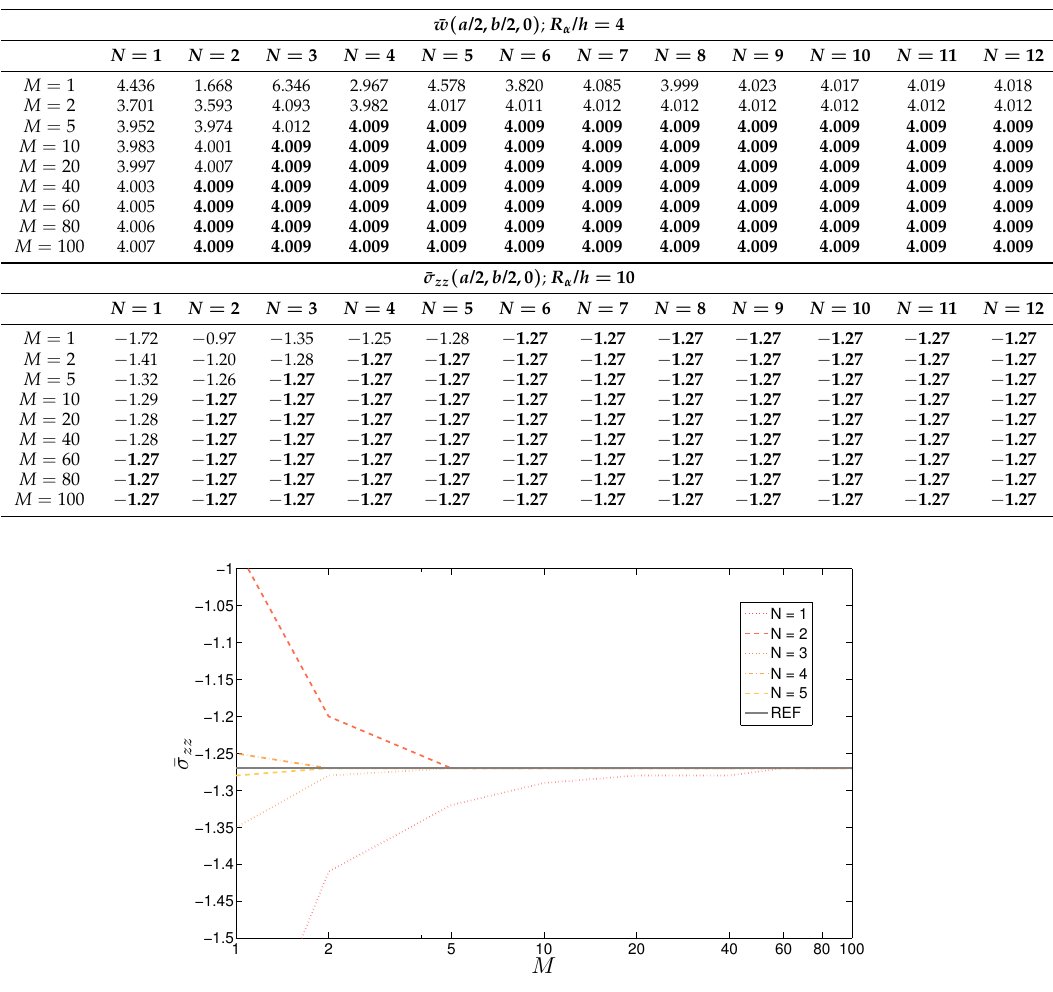
Figure 6. Case 3, simply supported composite laminated cylinder with thickness ratio R α / h = 10. Stress ¯ σ zz vs. number M of mathematical layers introduced for different orders of expansion N for the exponential matrix. REF means 3D solution by Varadan and Bhaskar